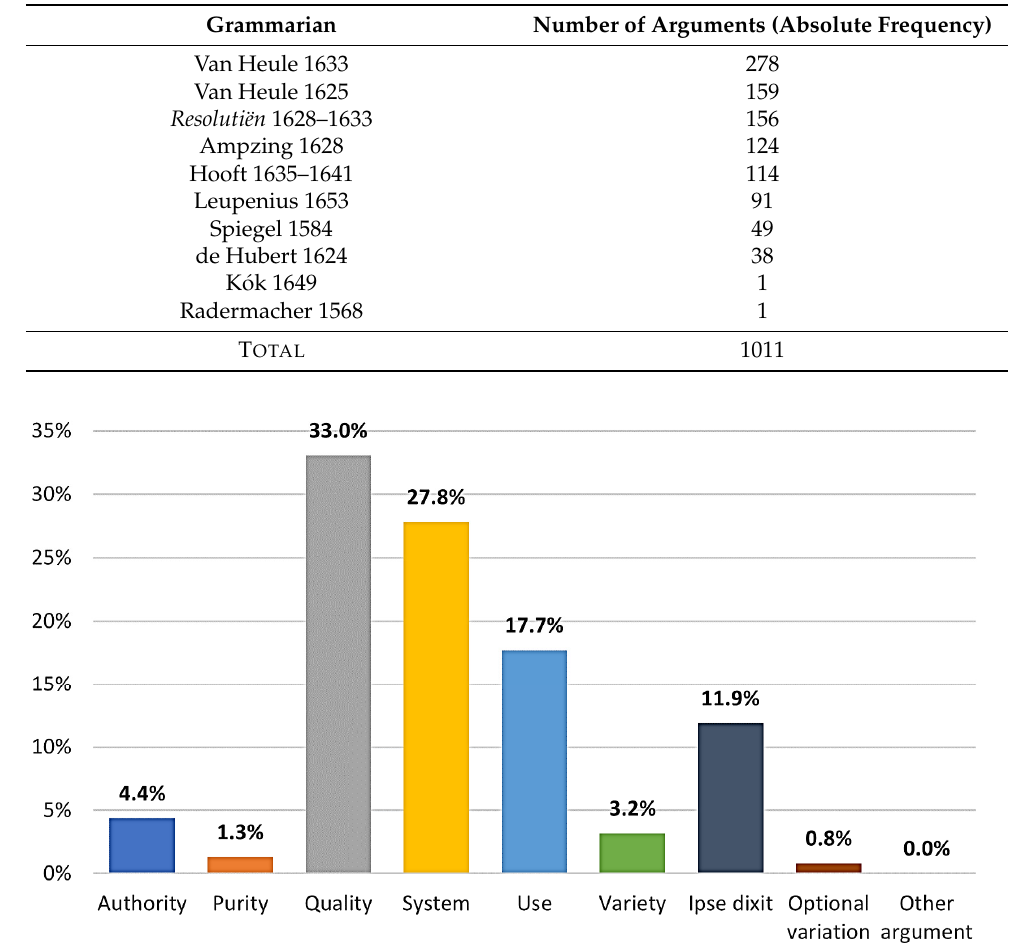
Figure 3. Types of arguments (top-level) used in normative works on Standard Dutch from ca. 1550 to 1650 (percentage of total, total number of arguments: n =